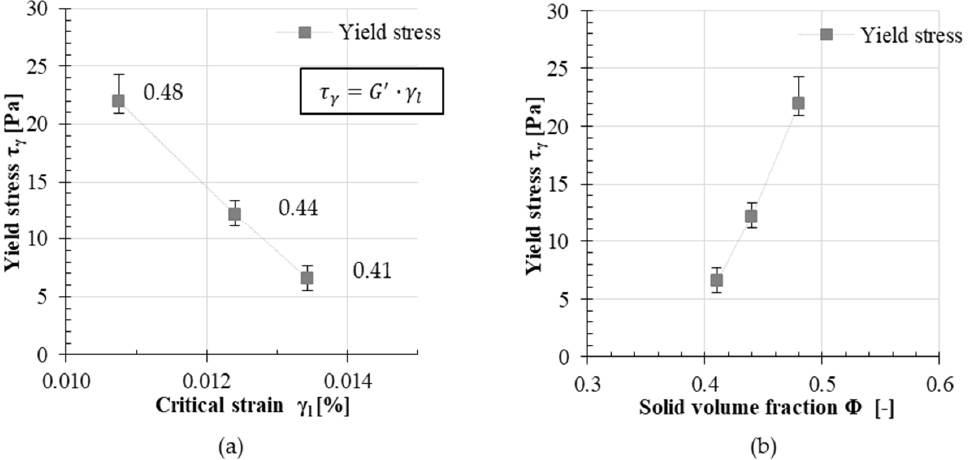
Figure 2. Calculated yield stress values of the test series 0.41, 0.44 and 0.48: ( a ) dependent on measured critical strain γ l and ( b ) dependent on solid volume fraction Φ (error bars indicate the magnitude of a standard deviation) .